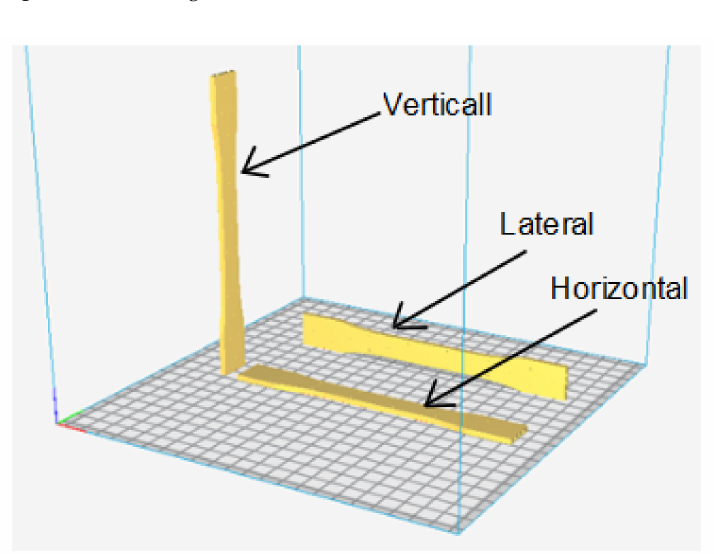
Figure 4. Raster angle.